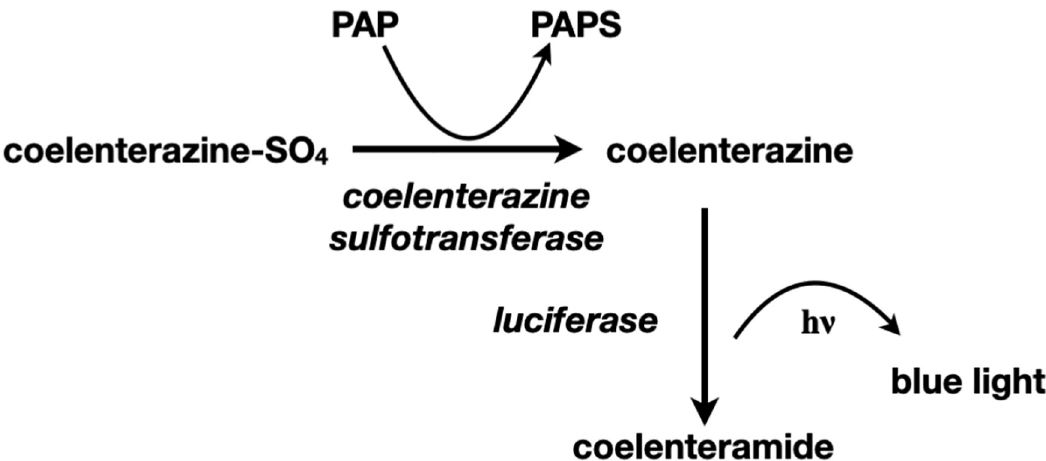
Fig 3. Cascade for conversion of coelenterazine sulfate to coelenteramide with concomitant emission of light utilizing PAP as the sulfate